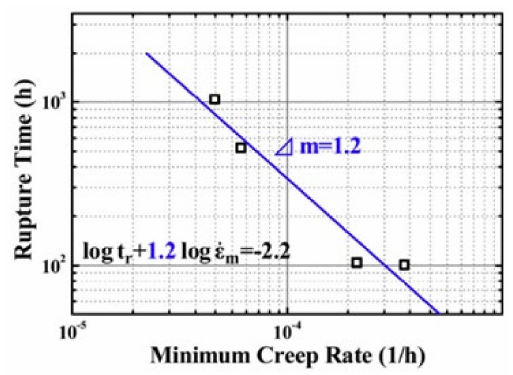
Figure 14. Relationships between creep rupture time and the minimum creep rate of Fe-18Ni-12Cr- based AFA steel at 700 ◦ C